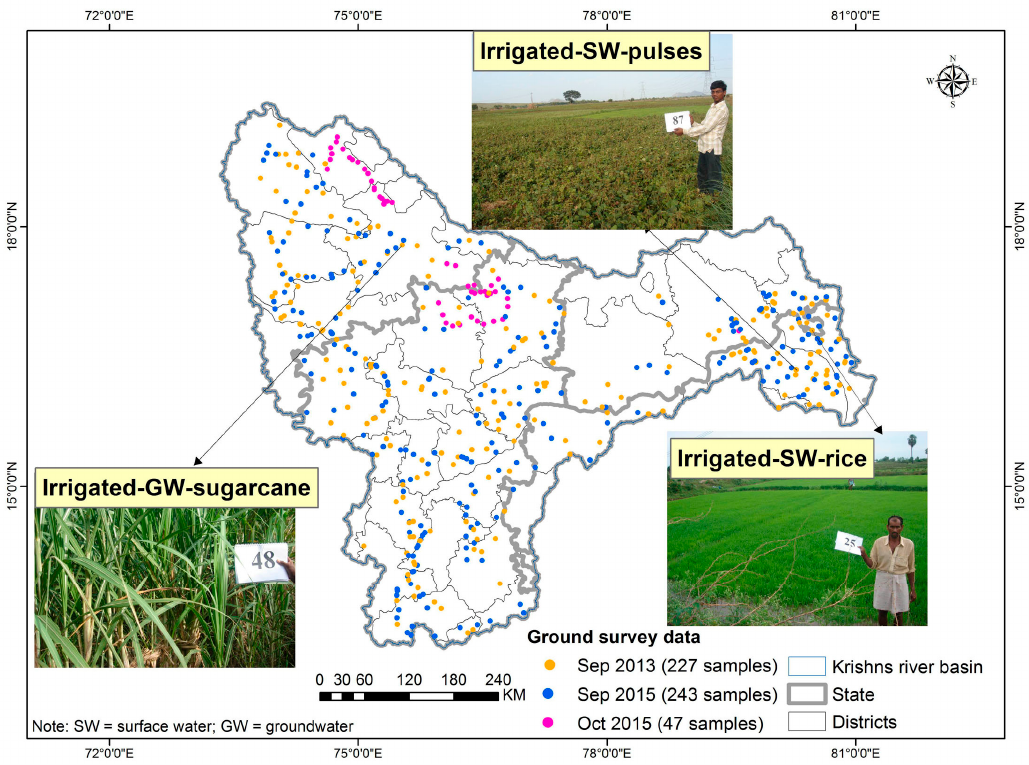
Figure 2. Ground survey locations in the Krishna River Basin and representative photographs taken during the survey.